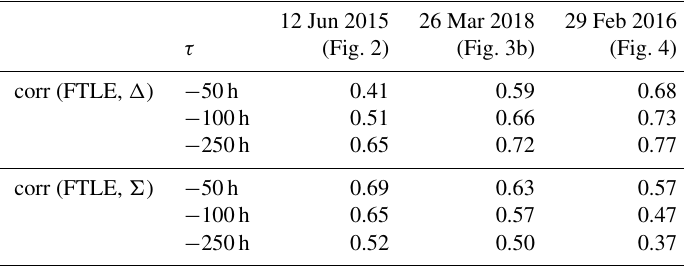
Table 1. Correlations between FTLE and its additive components (cid:49) and (cid:54) (see Eq.